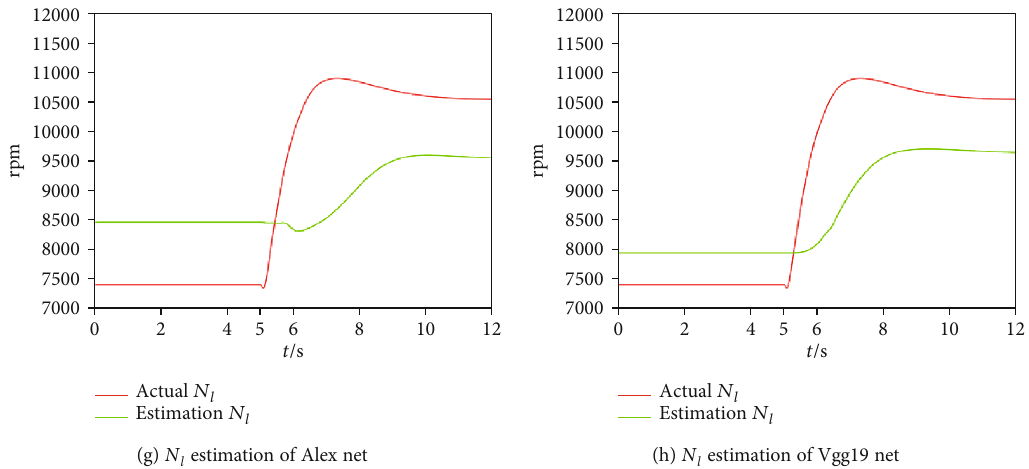
Figure 5: N l estimation in dynamic process of all eight convolutional neural networks.